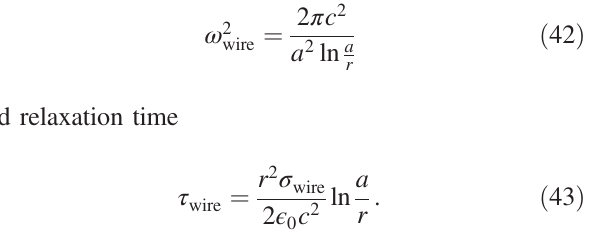
FIG. 10. A 1D wire-array metamaterial consisting of a rec- tangular array of parallel wires with spacing a and wire radius r . These dimensions combined with the wire conductivity σ specify the plasma frequency and the relaxation time of the metamaterial. Since the wires are aligned along the z axis, it is only the z component of the electric field which can electrically polarize the wires. The x - and y -field components are unaffected by the array.